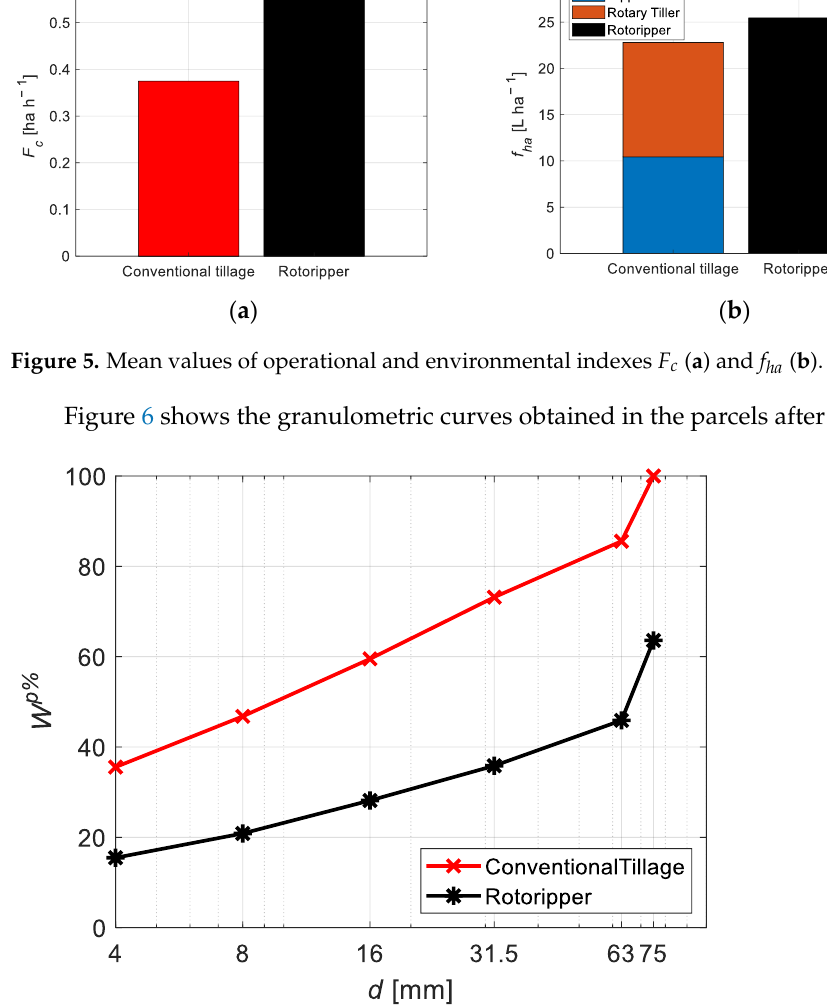
Figure 6. Granulometric curves obtained with conventional tillage and the Rotoripper.